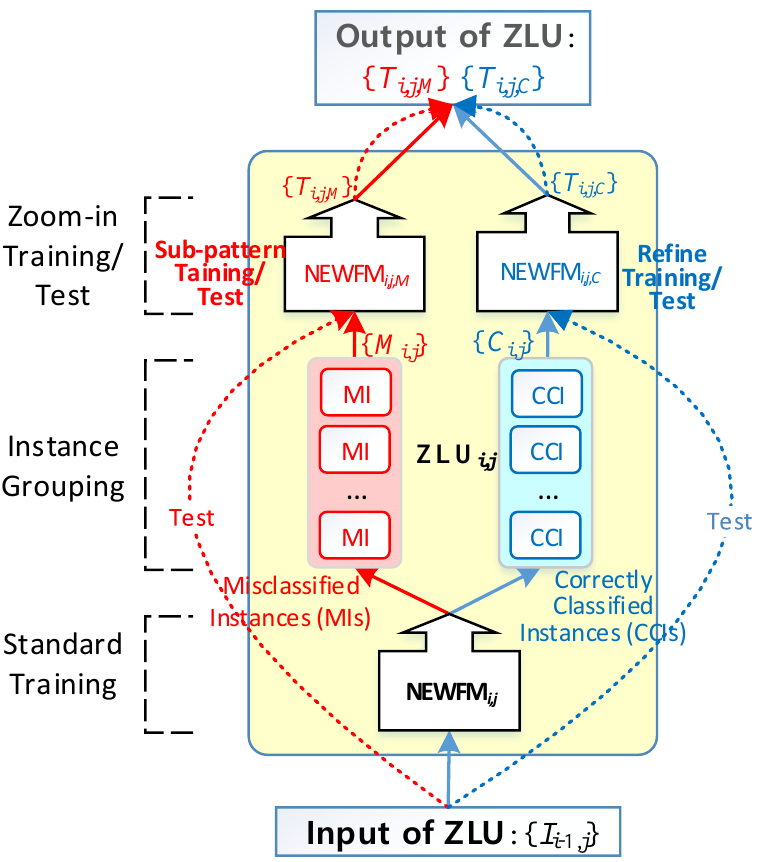
Figure 2. Structure of the Zoom-in Learning Unit (ZLU)(solid lines denote training and dotted lines denote